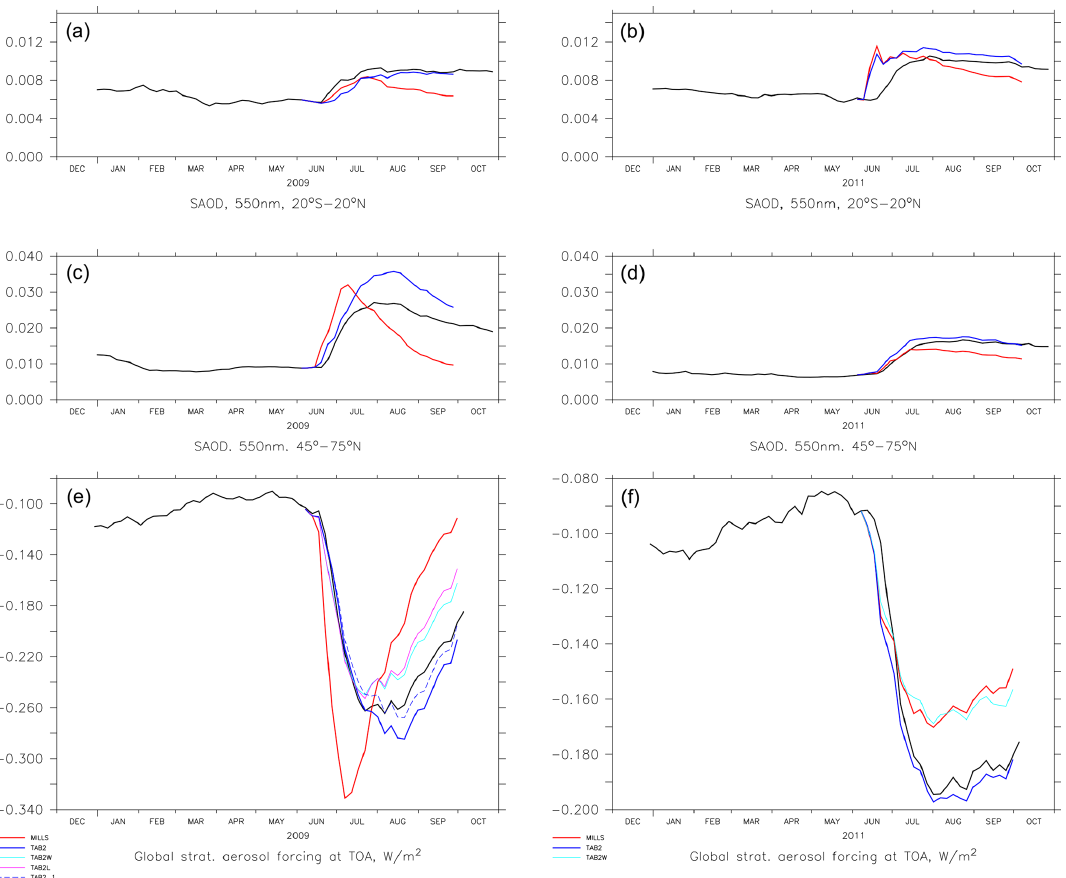
Figure C4. Stratospheric AOD (a–d) and global radiative forcing at the TOA (e, f) , Sarychev (a, c, e) and Nabro (b, d, f) , black line like the red line in Figs. 9 or 11, blue, light blue and purple line “point sources” based on Table 2 with different thicknesses and vertical positions of the column into which this is injected (see text), and red lines with the assumptions of Mills et al. (2016). Dashed blue, light blue, and purple curves: see